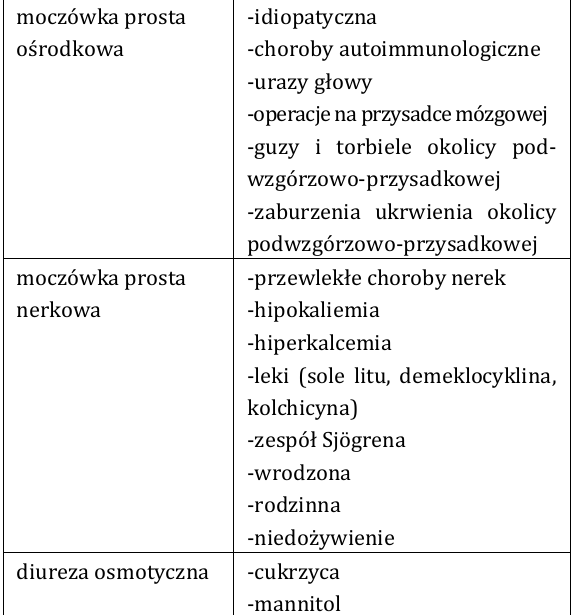
Tab.1 Przyczyny polidypsji